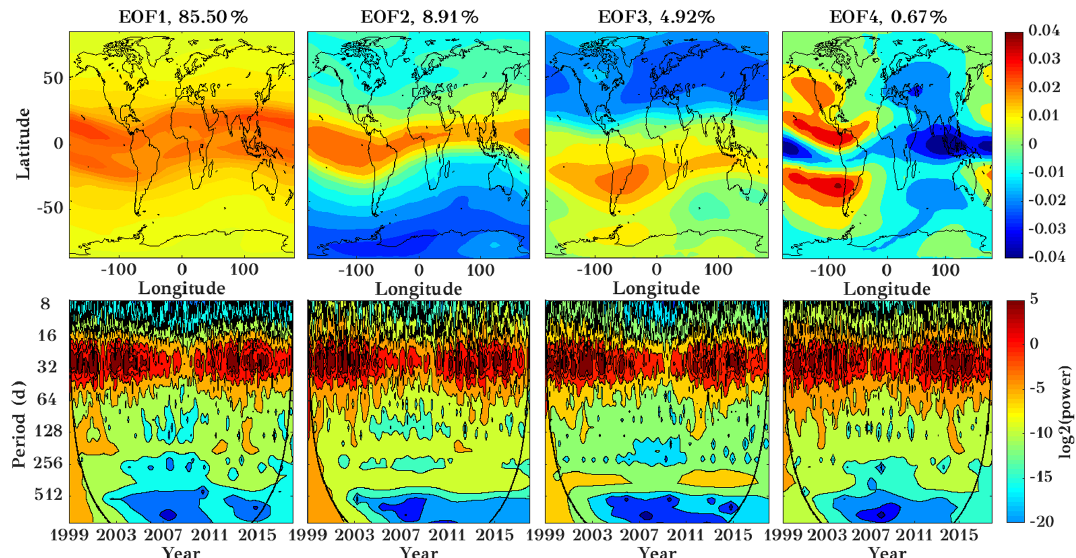
Figure 13. Spatial distribution map of first four EOFs (upper panels) of IGS TEC during the years 1999 to 2017, and their corresponding wavelet transform (lower panels, wavelet power in log2 scale) using a 25–35d filtered dataset. The EOFs are